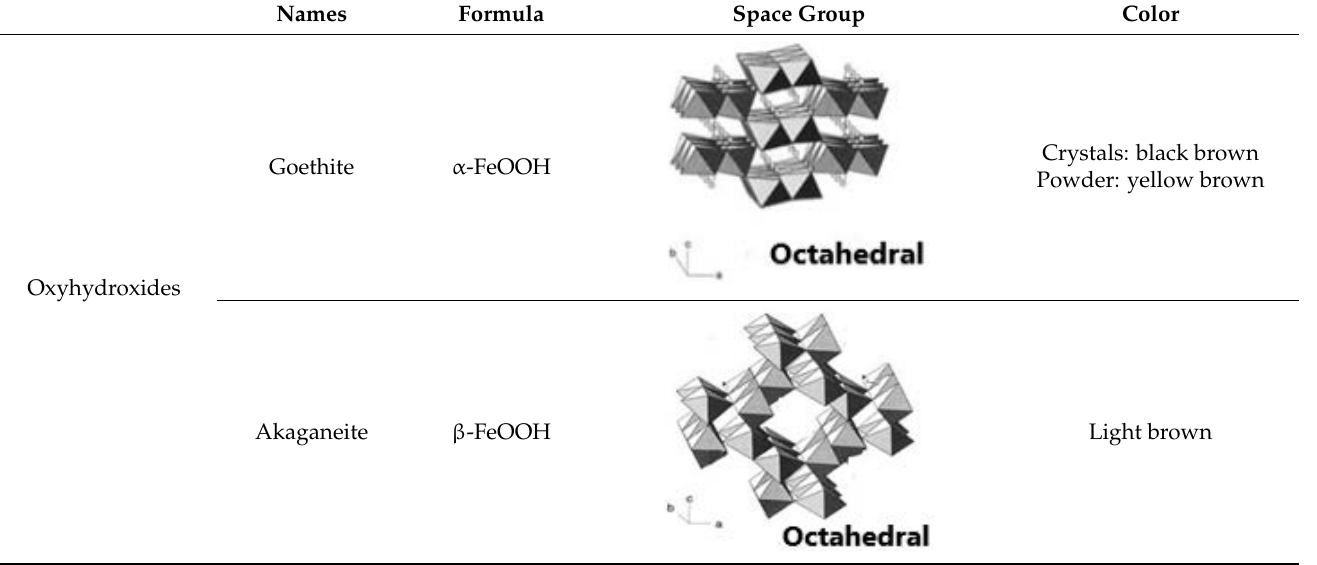
Table 1. Iron oxides and oxyhydroxides encountered in rust layers resulting from atmospheric corrosion [15,33,34].